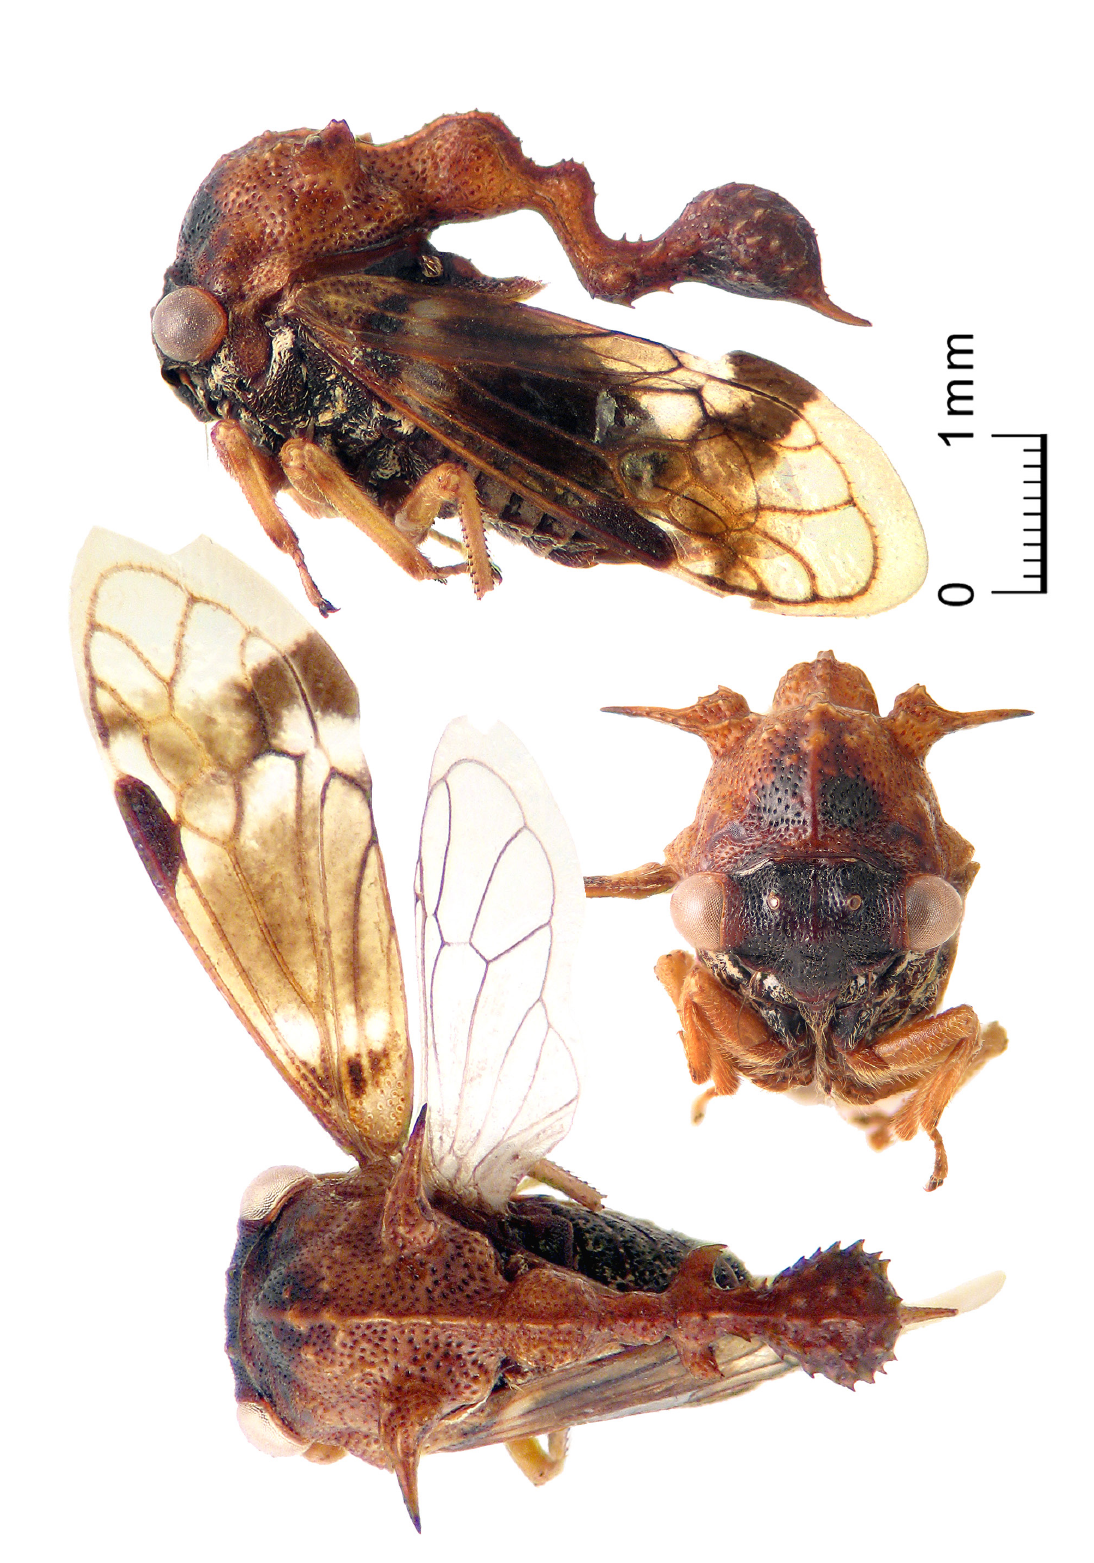
Fig. 2. Hamma spinellii sp. nov., holotype, ♀, Gabon, Ogouè Ivindo, Mont Sassamongou, Batouala, 30 Nov. 2012, A. Susini leg.